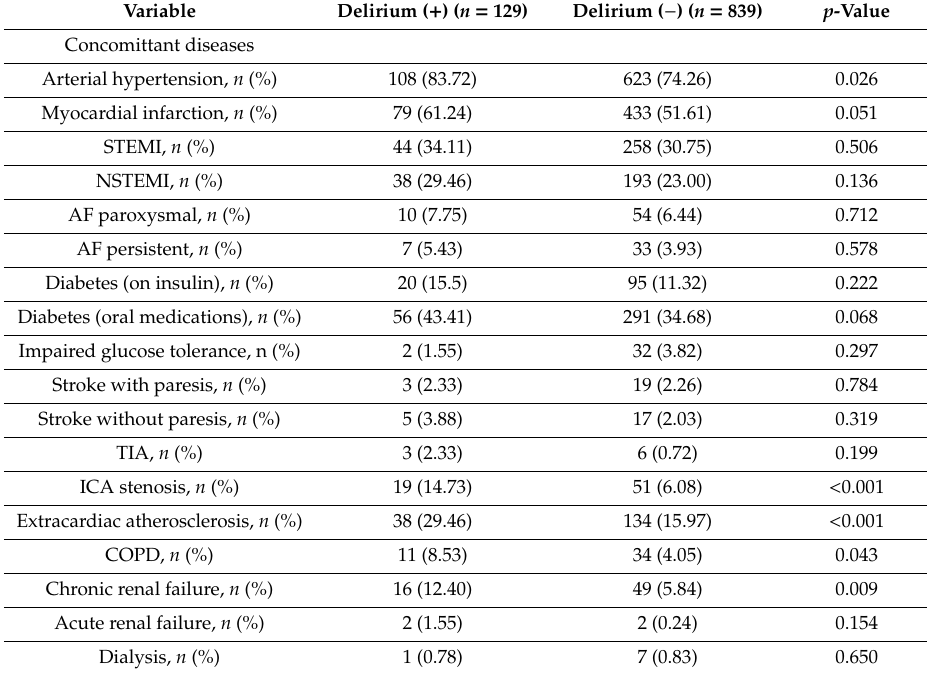
Table 2. Co-morbidities in both study groups with delirium and without POD after CABG. POD, Postoperative delirium; CABG, coronary artery bypass